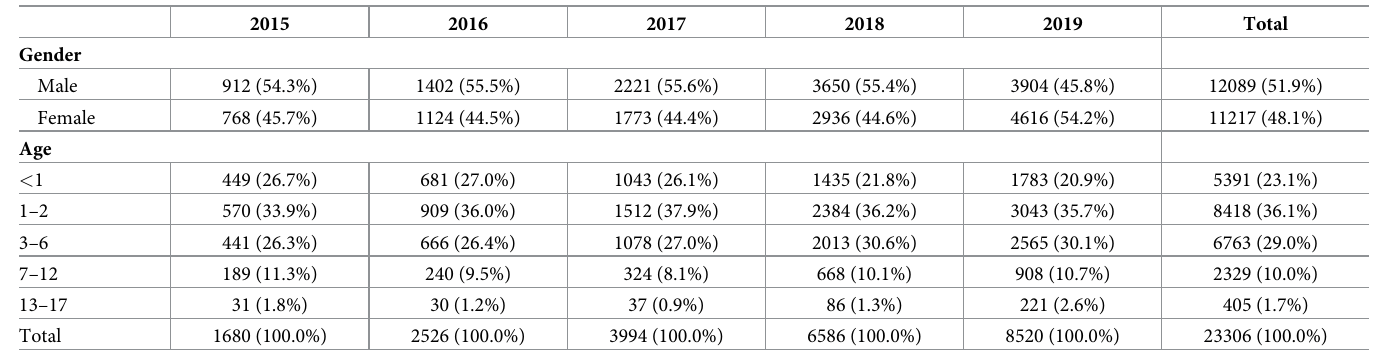
Table 1. Demographic data of the paediatric population analysed from year 2015 to 2019.